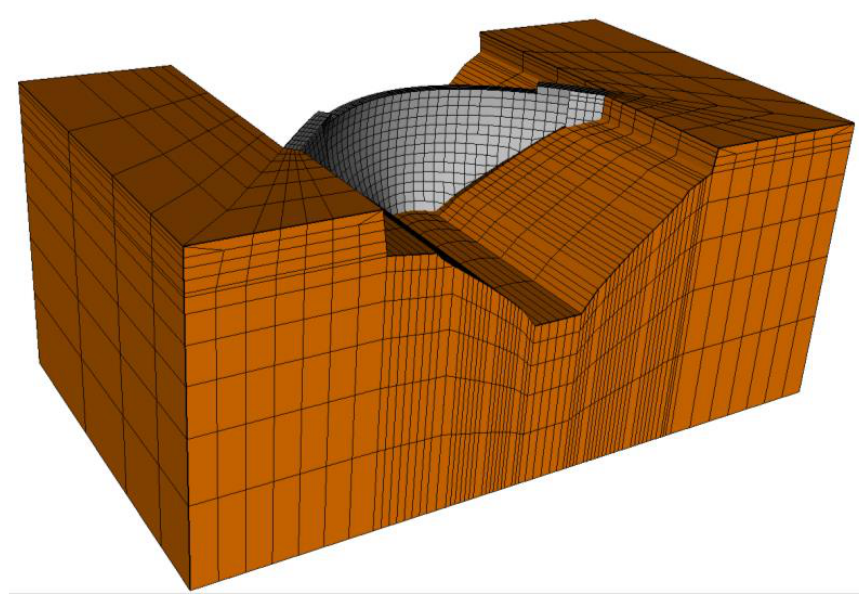
Figure 6. Finite element model of Alto Ceira II dam.